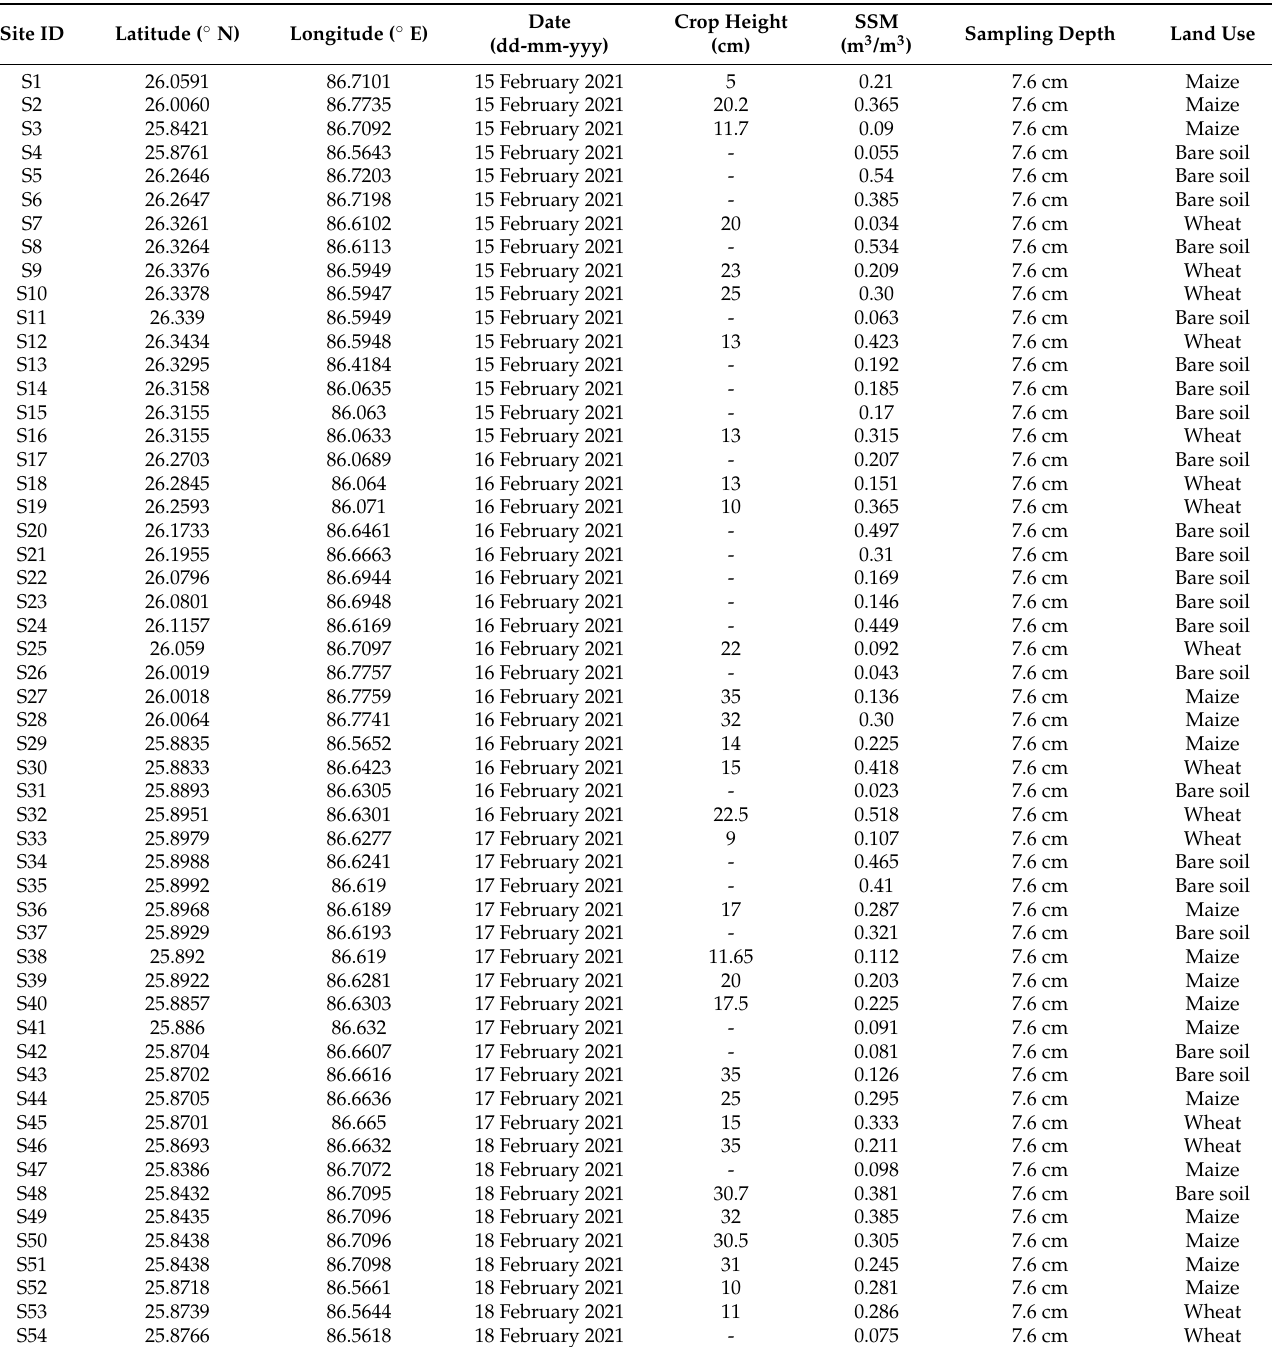
Table A1. Measurement of in-situ SSM using TDR-300 at different sample plots in KRB and corre- sponding